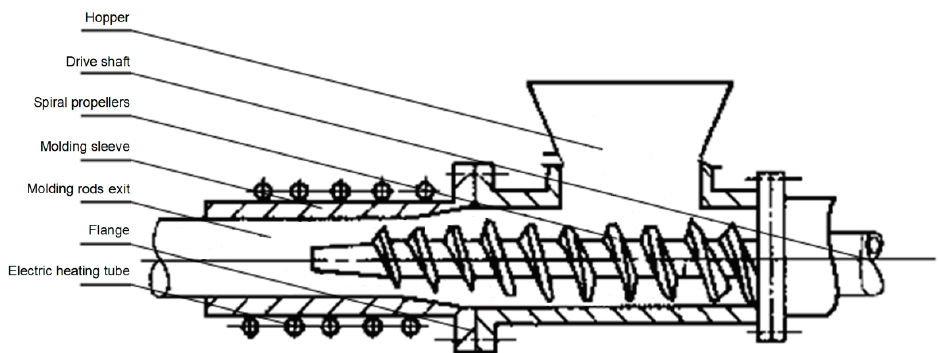
Figure 6. Schematic diagram of the briquetting